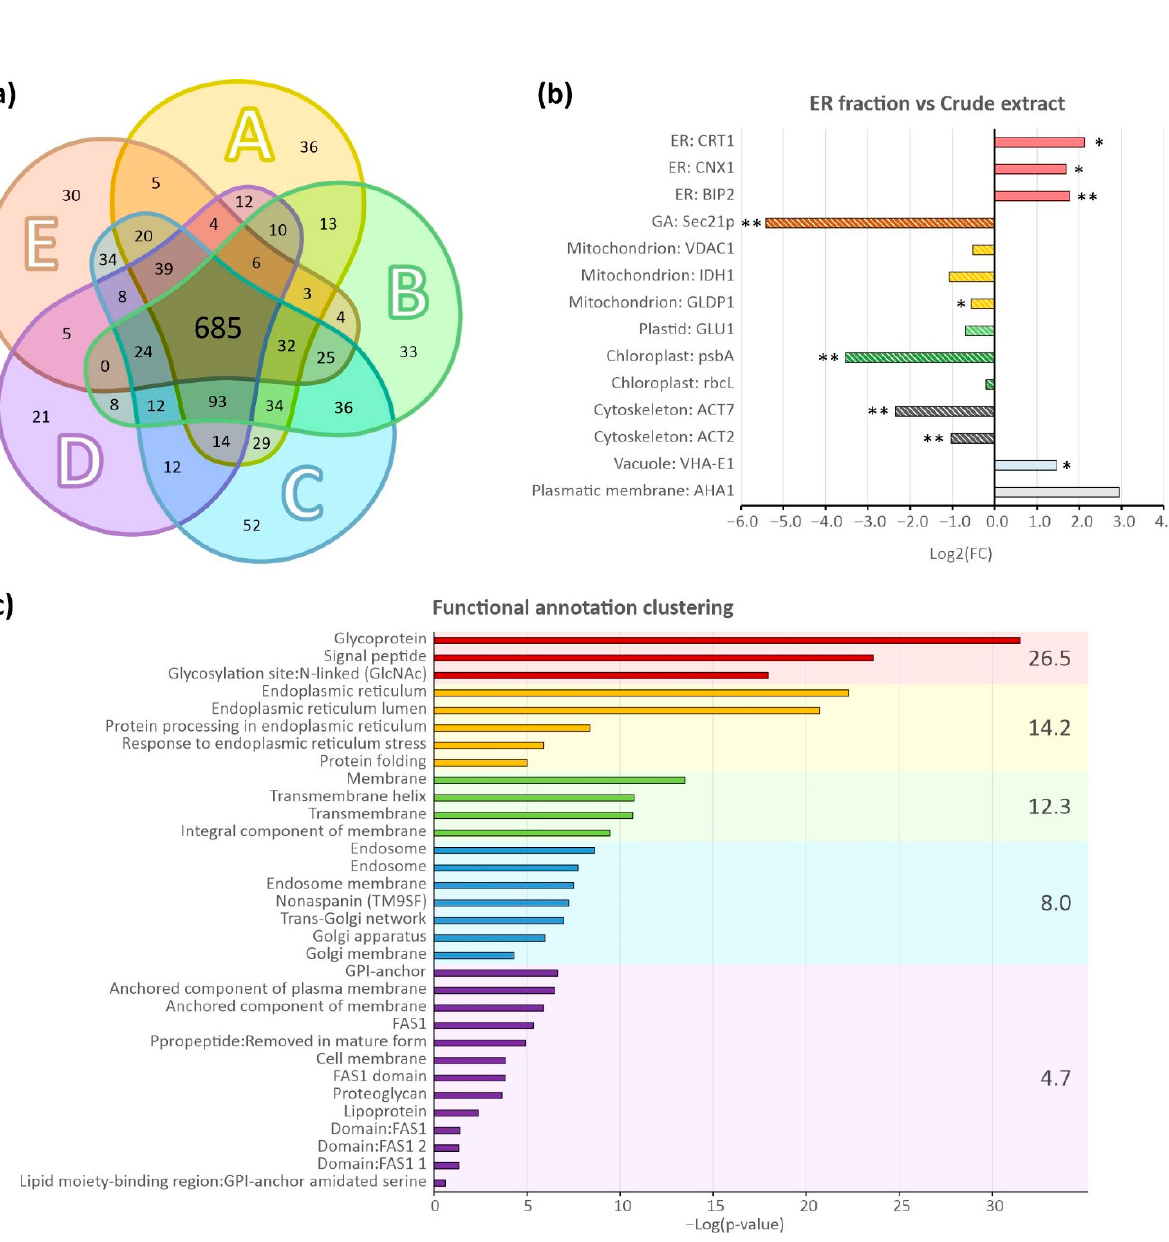
Figure 4. Proteomic analysis of the prepared ER fractions. ( a ) Protein identification overlaps for the analysed independent ER isolates ( n = 5). The capital letters (A,B,C,D,E) stand for the individual ER isolation replicates. Numbers show the total sums of protein identifications belonging to the particular sections of the Venn diagram. ( b ) Distribution of Log2 fold changes (FC) of known protein organelle markers. Fold changes were calculated from the ratios of the iBAQ values for the respective markers identified in the analysed ER isolates ( n = 5) to those in control samples (total protein lysates from 10-days old Arabidopsis seedlings; n = 5). Asterisks denote significant differences (* for p ≤ 0.05 and ** for p ≤ 0.01). ( c ) Clustering of significantly enriched functional annotation terms for the identified proteins whose location was assigned as the ER. The colours of bars and the background indicate the annotation cluster of the protein. The clusters are sorted according to their enrichment score that is presented on the right side of the graph, and the individual functional terms are sorted by the negative log of their p -value. Endoplasmic reticulum (ER), Golgi apparatus (GA).